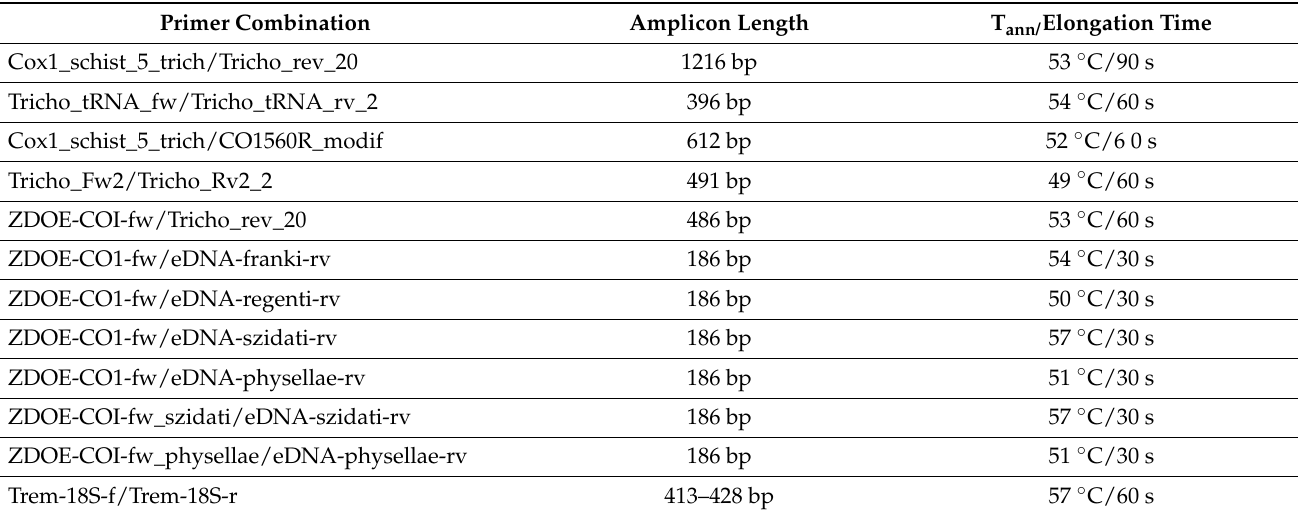
Table 4. Conditions of PCR reactions as well as amplicon lengths for the different primer pairs. T ann = annealing temperature.